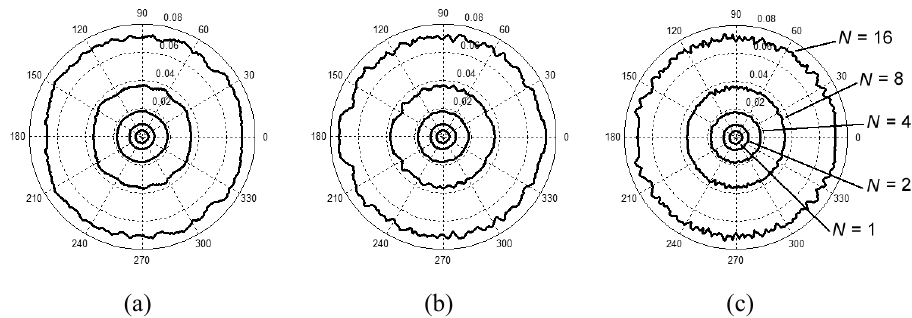
Fig. 1 . The signal power P rx (α, r ) of the ensemble for N =1, 2, 4, 8, 16 UWB chaotic sources. r = 200  . Distance of the emitters in the linear grid (a) d =  /2, (b) d =  , (c) d = 2  (  is average wavelength of UWB chaotic